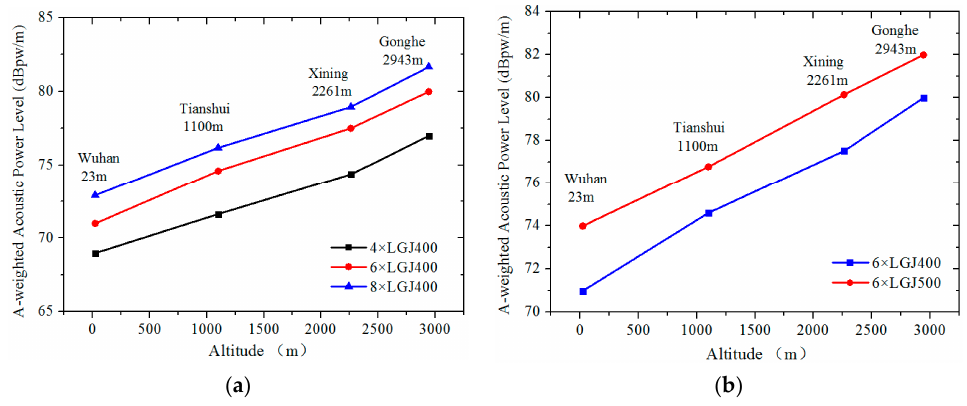
Figure 6. Comparison of PWL values between different bundled conductors: ( a ) same subconductor diameters with different bundle number; ( b ) same bundle number with different subconductor diameter.